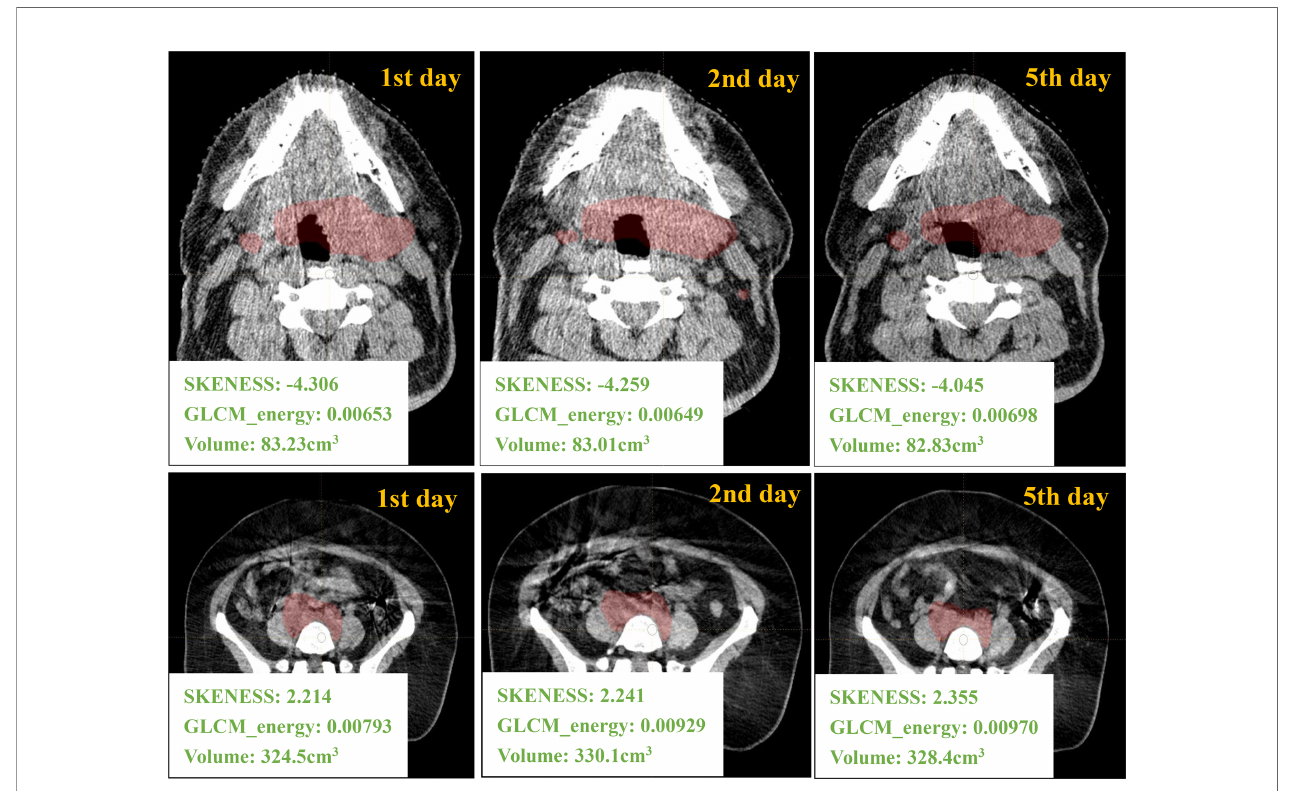
FIGURE 2 | Different days of CBCT images and the corresponding radiomics/volume values from one H&N ROI and one pelvic